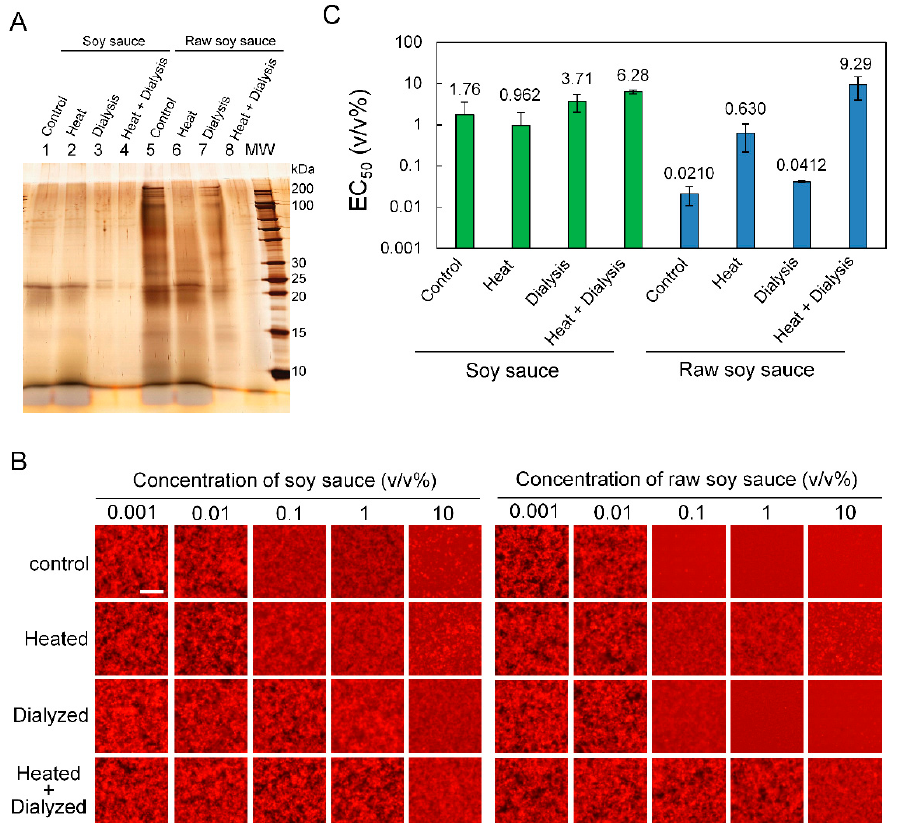
Figure 6. Influence of heat and dialysis treatment on A β 42 aggregation inhibitory activity of soy sauce and raw soy sauce. ( A ) SDS-PAGE analysis demonstrated that heating and dialysis treatments changed the band pattern of soy sauce and raw soy sauce. Lanes 1–4: soy sauce; lanes 5–8: raw soy sauce. Lanes 1 and 5: control; lanes 2 and 6: heat treatment; lanes 3 and 7: dialysis treatment; lanes 4 and 8: dialysis and heat treatment. MW: molecular weight marker. ( B ) Fluorescence images of A β 42 aggregates in each condition. Effect of heating and dialysis treatment on A β 42 aggregation inhibition of soy sauce and raw soy sauce. All images were captured using a conventional fluorescence microscope. Bars: 100 μ m. ( C ) A β 42 aggregation inhibitory activity (EC 50 ) of soy sauce and raw soy sauce